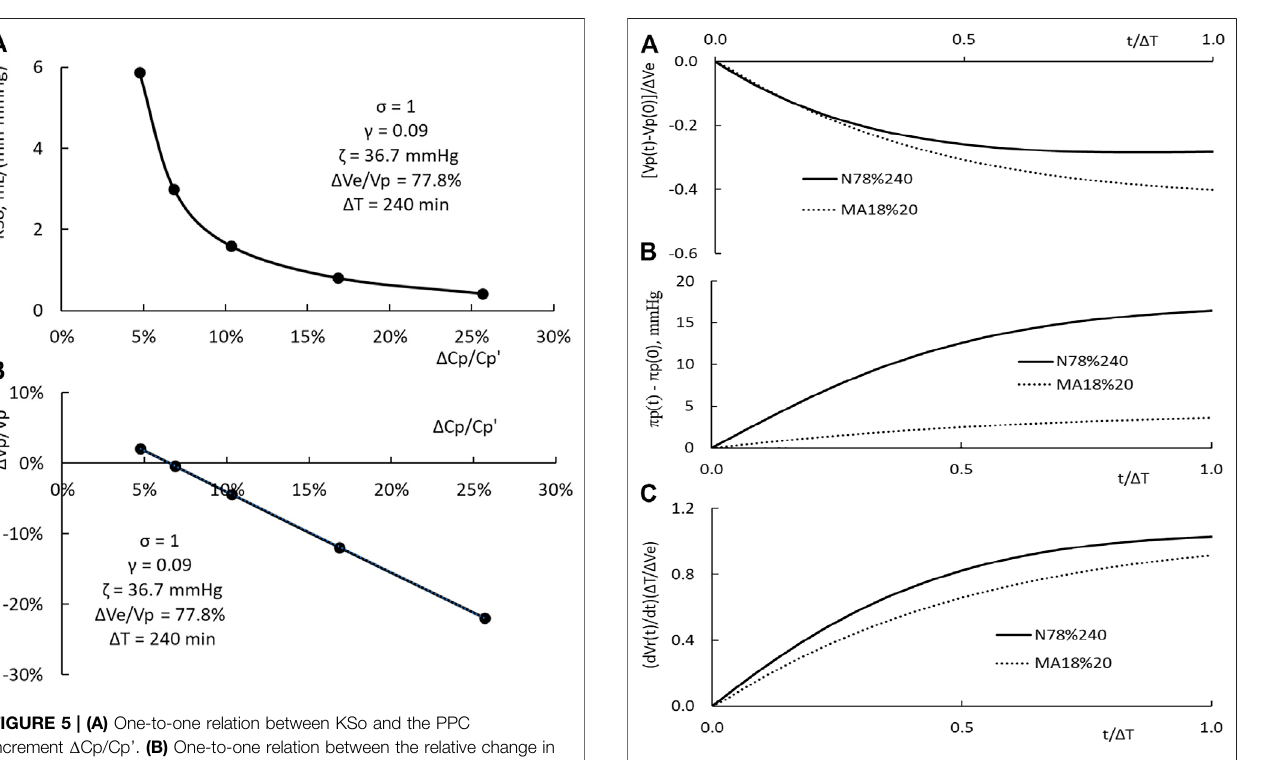
FIGURE 6 | (A) Temporal changes in plasma volume of N78% HD carried out in patients with normal hematocrit (solid line) and that MA18%20 HD carried out in patients with more anemic hematocrit (dotted line). (B) Temporal changes in plasma COP π p(t) of the two HDs. (C) Temporal changes in the normalized rate of restitution